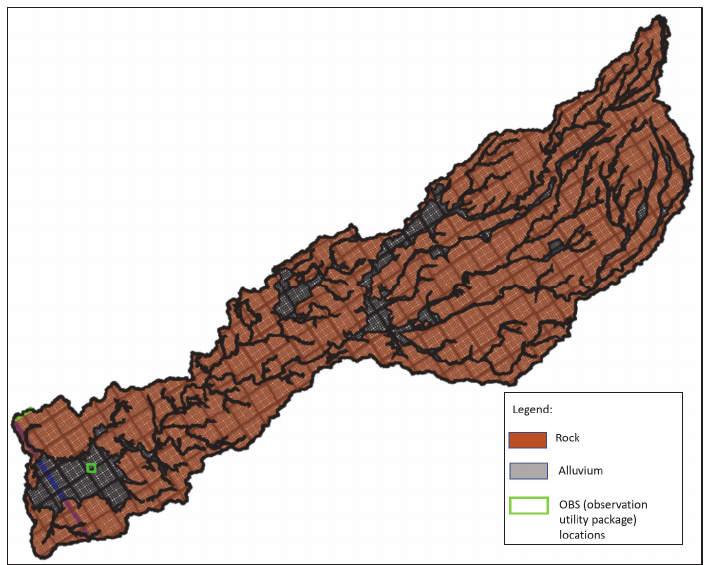
Figure 17. OBS (observation utility package) during transient groundwater modeling stage, that located at Hadat Ash ‐ Sham Farm Station.